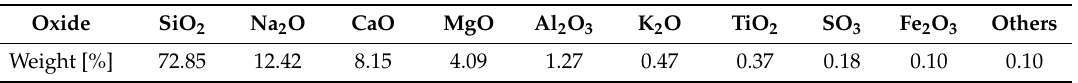
Table 2. by weight composition of commercial soda-lime glass. In iron-free glass, iron oxide (Fe 2 O 3 ) is discarded from the starting